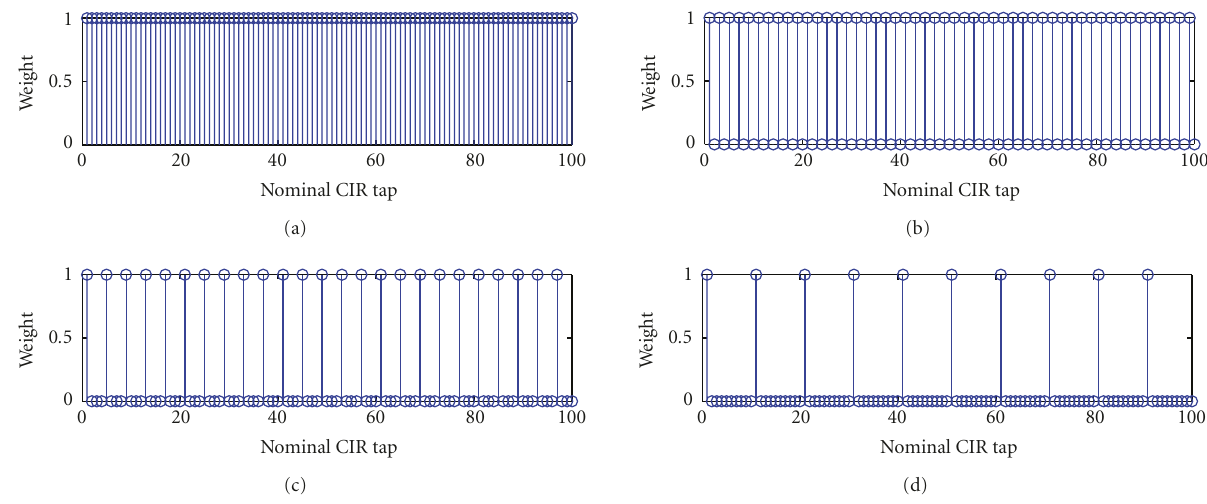
Figure 13: Normalized evenly spaced nominal CIR taps of sparse channels. (a) K = 100% (b) K = 50% (c) K = 25% (d) K = 10%.